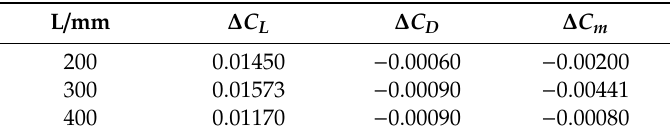
Figure 9. Support interference results of the BWB aircraft with different straight-section lengths (L = Figure 10. Pressure contour and distribution of the BWB aircraft with different straight-section lengths (L = 200 mm/300 mm/400 mm, Ma = 0.75, α = 0°): ( a ) pressure contour of the BWB aircraft under the L = 200 mm condition; ( b ) pressure distribution of profile F-F (position of F-F is shown in Figure 10a).